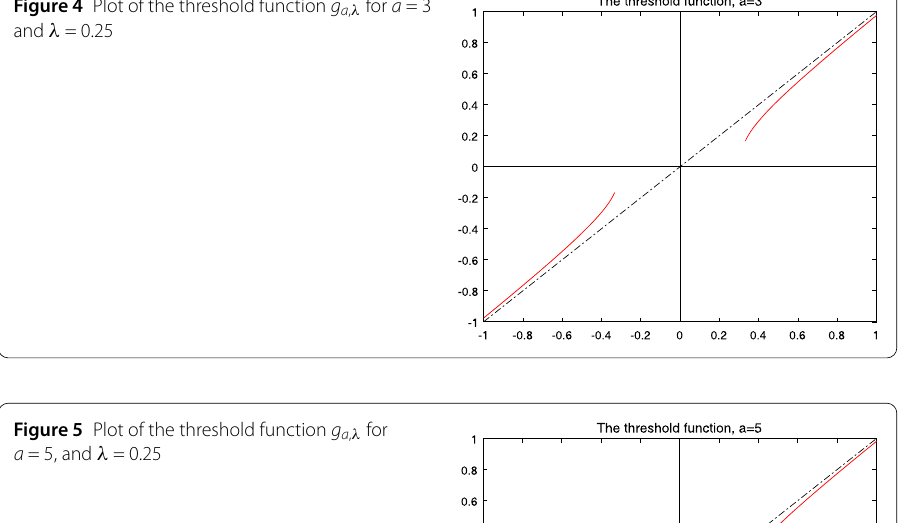
Figure 5 Plot of the threshold function g a , λ for a = 5, and λ = 0.25